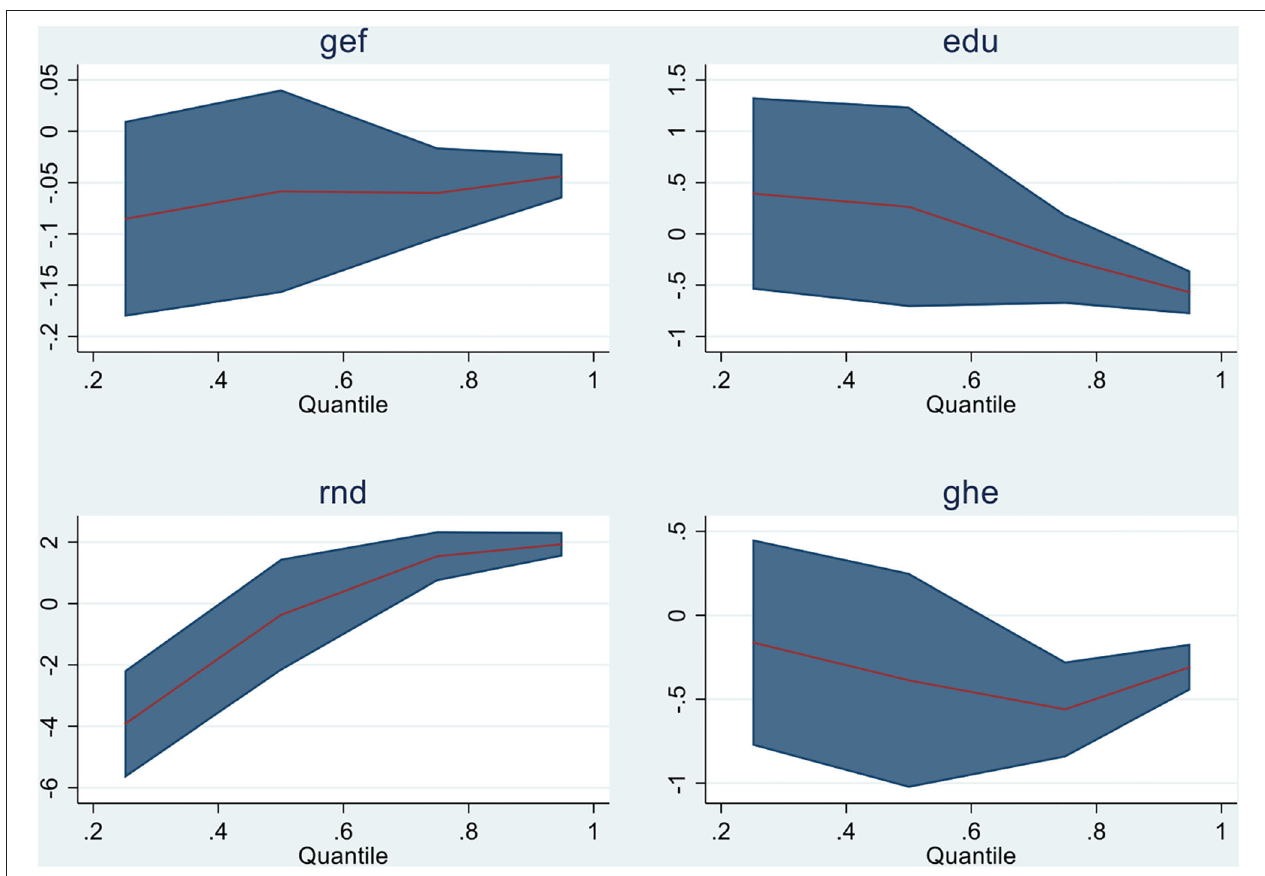
FIGURE 2 | Graphical representation of quantiles for Model